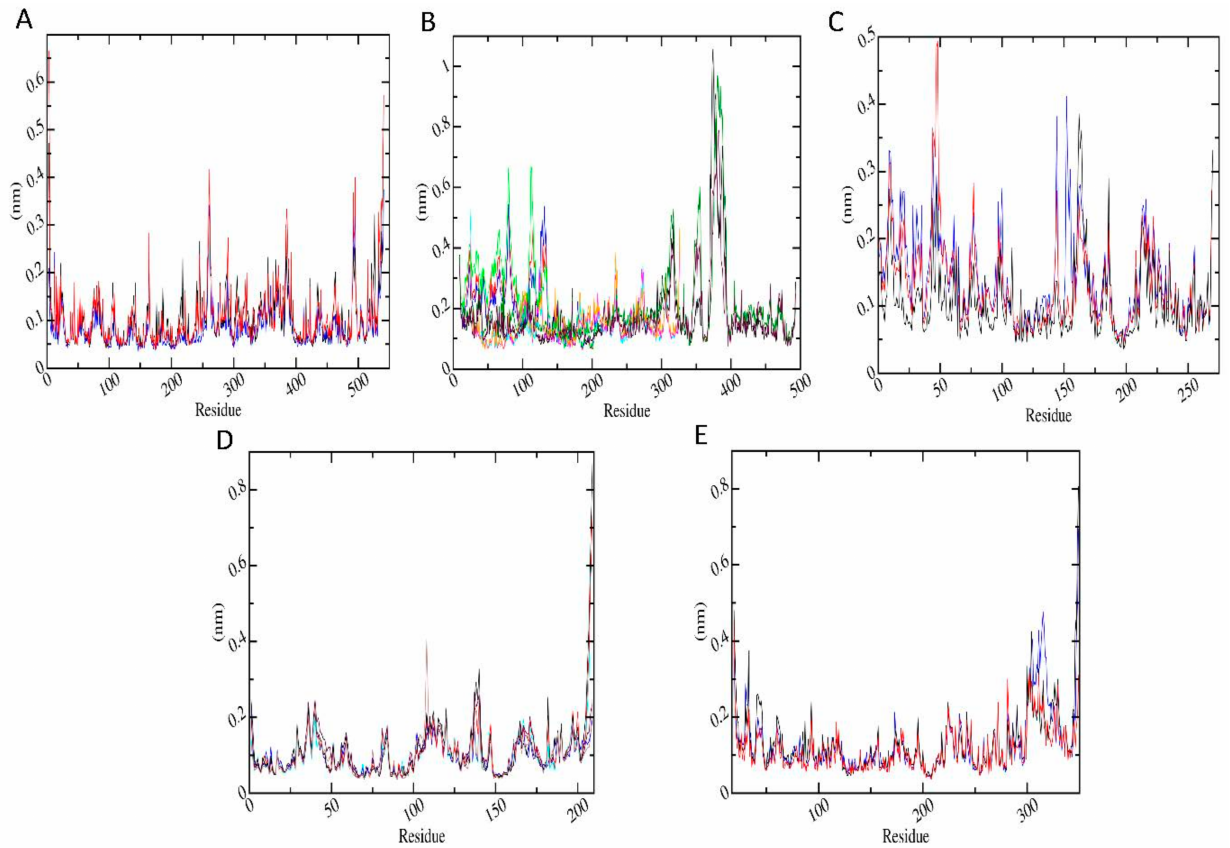
Figure 6. Plot root mean square fluctuation (RMSF) (nm) versus simulation time (pS). Plot A , C , E indicate AChE-FM/FMS, ASK1-FM/FMS, PKC-IM/6-CIPHD complexes, respectively, where black color plots represent parent pesticides, red color plots represent metabolites, and blue color represents apo-enzymes. ( B ) The RMSF of three subunits of AMPK-FN complex are indicated in black, blue, and cyan. Similarly, the RMSF of three subunits of AMPK-FNS complex are indicated in red, magenta, and maroon. Sub-units for apo-AMPK are indicated in dark green, light green, and orange ( D ) The RMSF of two subunits of GST-IM complex are indicated in black and brown. Likewise, the RMSF of two subunits of GST-6CIPHD complex are indicated in red and magenta, while apo-GST subunits are indicated in blue and